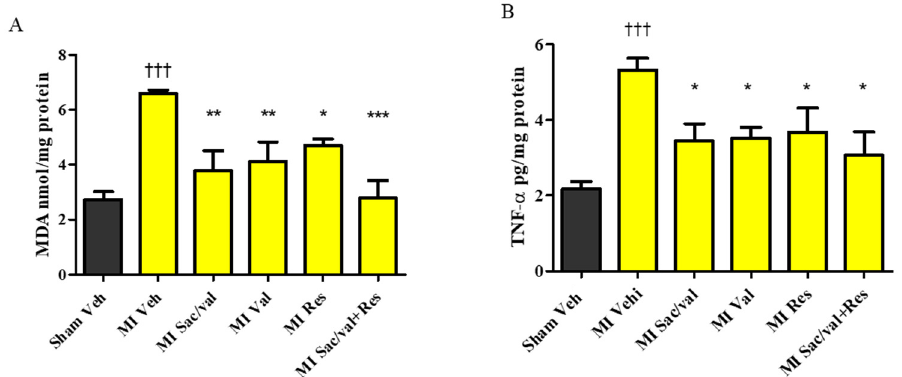
Figure 4. ( A ) Malondialdehyde (MDA); ( B ) Tumor necrosis factor- α (TNF- α ). All values are expressed as mean ± SEM, n = 4–6. ††† p < 0.001 vs. Sham Veh; * p < 0.05, ** p < 0.01, *** p < 0.001 vs. MI